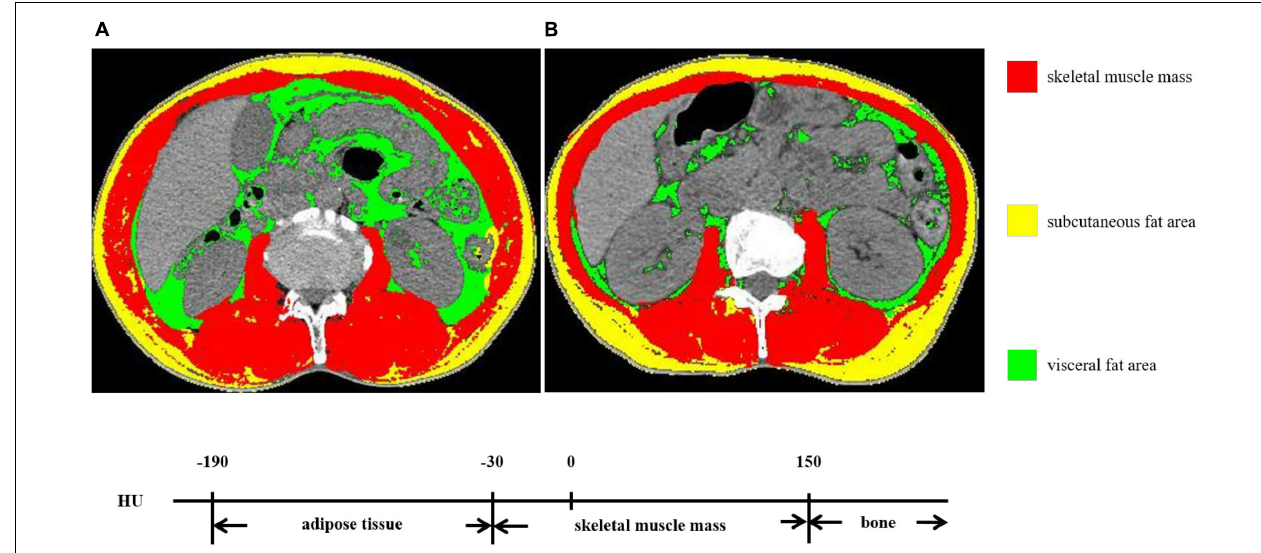
FIGURE 1 | The skeletal muscle mass and visceral fat area (VFA) at the third lumbar vertebra. (A,B) exhibited two patients with the same BMI but different body compositions.